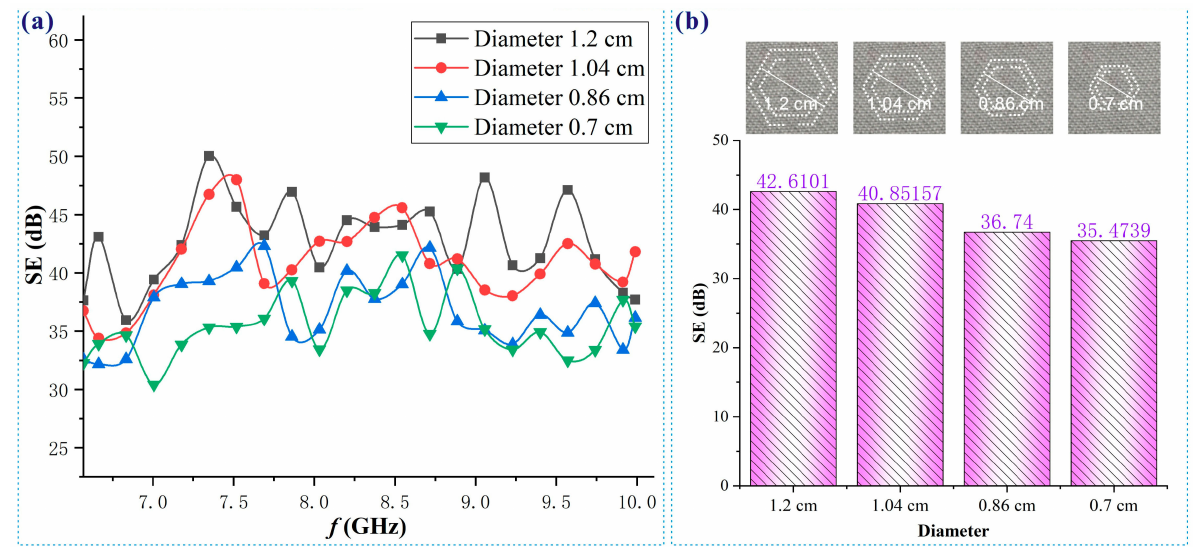
Figure 6. SE values of the fabrics with different diameters of the SRR. ( a ) Variation of the SE and ( b ) Average value of the